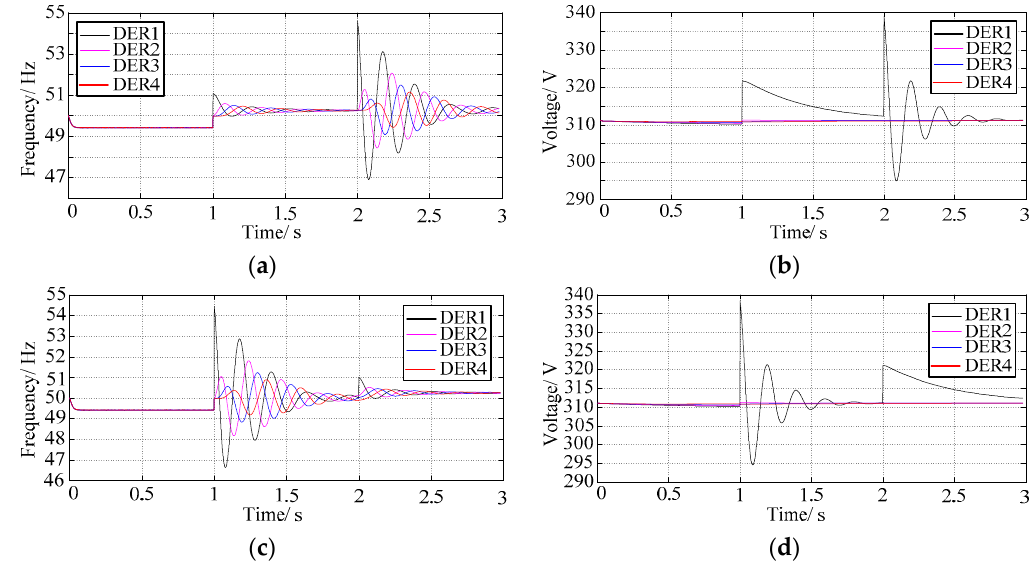
Figure 8. The effectiveness of the event-triggered mechanism; ( a ) the variations of voltage in Experiment 1; ( b ) the variations of frequency in the experiment 1; ( c ) the variations of voltage in Experiment 2. ( d ) the variations of frequency in Experiment